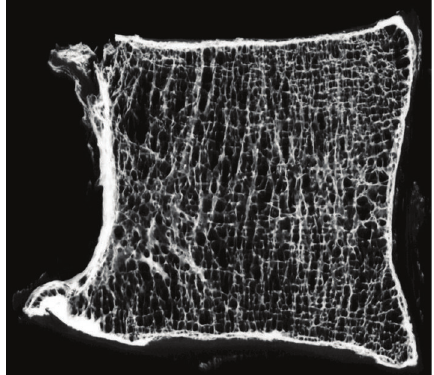
Figure 1: Microradiograph of a mid-sagittal-plane slice of an L2 vertebral body (male, aged 81 years), anterior on the left. Note the inferior trabecular architecture in the anterior region. (Reproduced with permission from Adams et al.